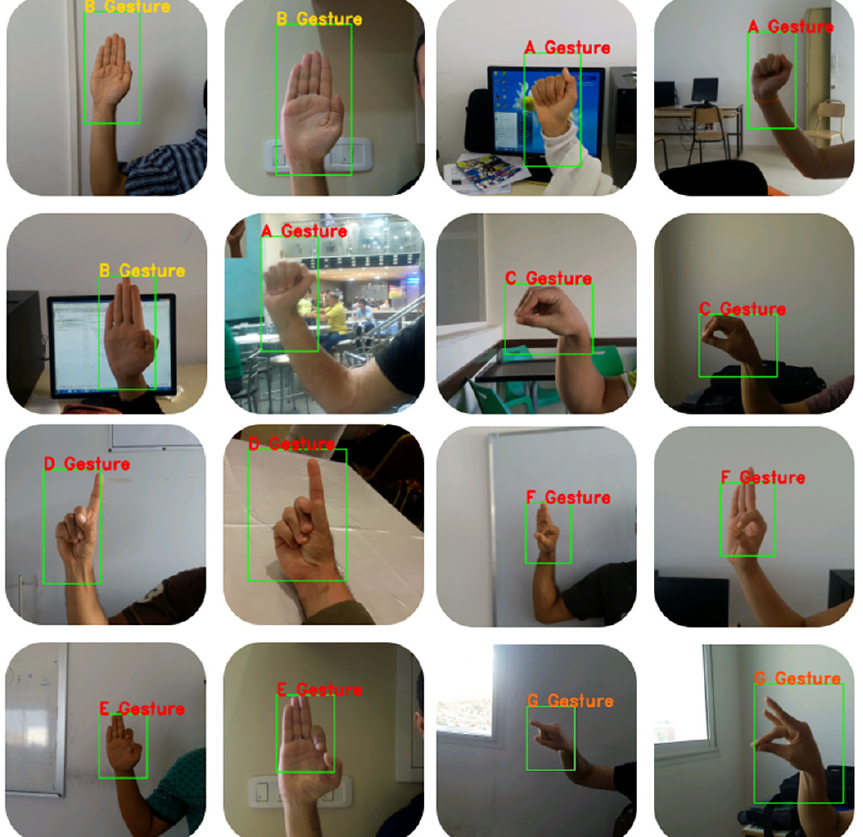
Fig. 4. Gestures detection with different persons and in different lightning conditions and